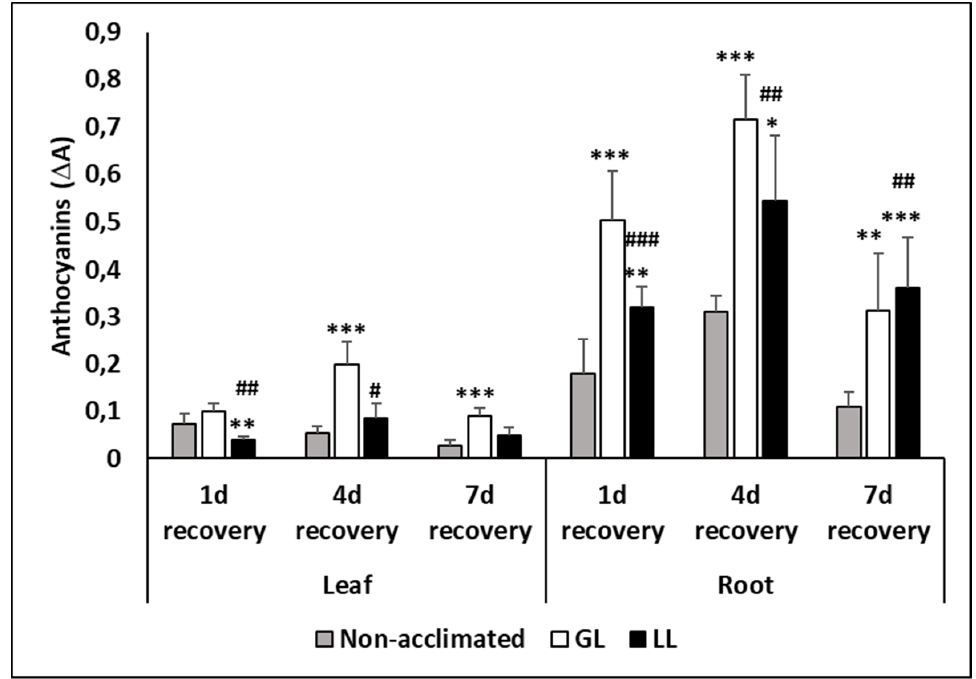
Figure 8. Changes in the anthocyanin contents during cold acclimation (15/13 °C), chilling (5 °C) and recovery in the leaves and roots of young maize plants. Light intensities during hardening: GL: 387 µmol m −2 s −1 ; LL: 107 µmol m −2 s −1 . *, **, *** significant differences compared to the control plants